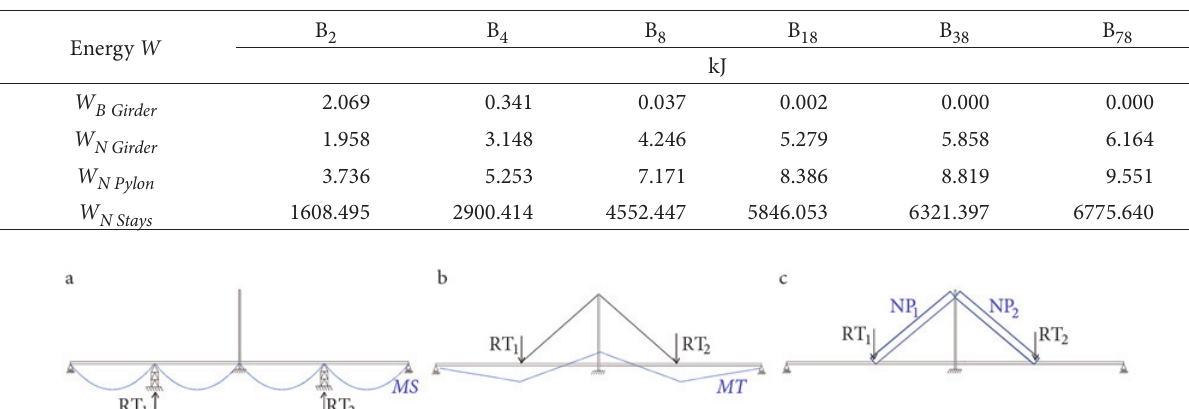
fig. 8. Model of a cable-stayed bridge with a staggered erection: a − bending moments after staggered erection of the superstructure MS ; b − bending moments after transferring the load of the temporary supports to the stay system MT , c − stay forces after transferring the load of the temporary supports to the stay system NT